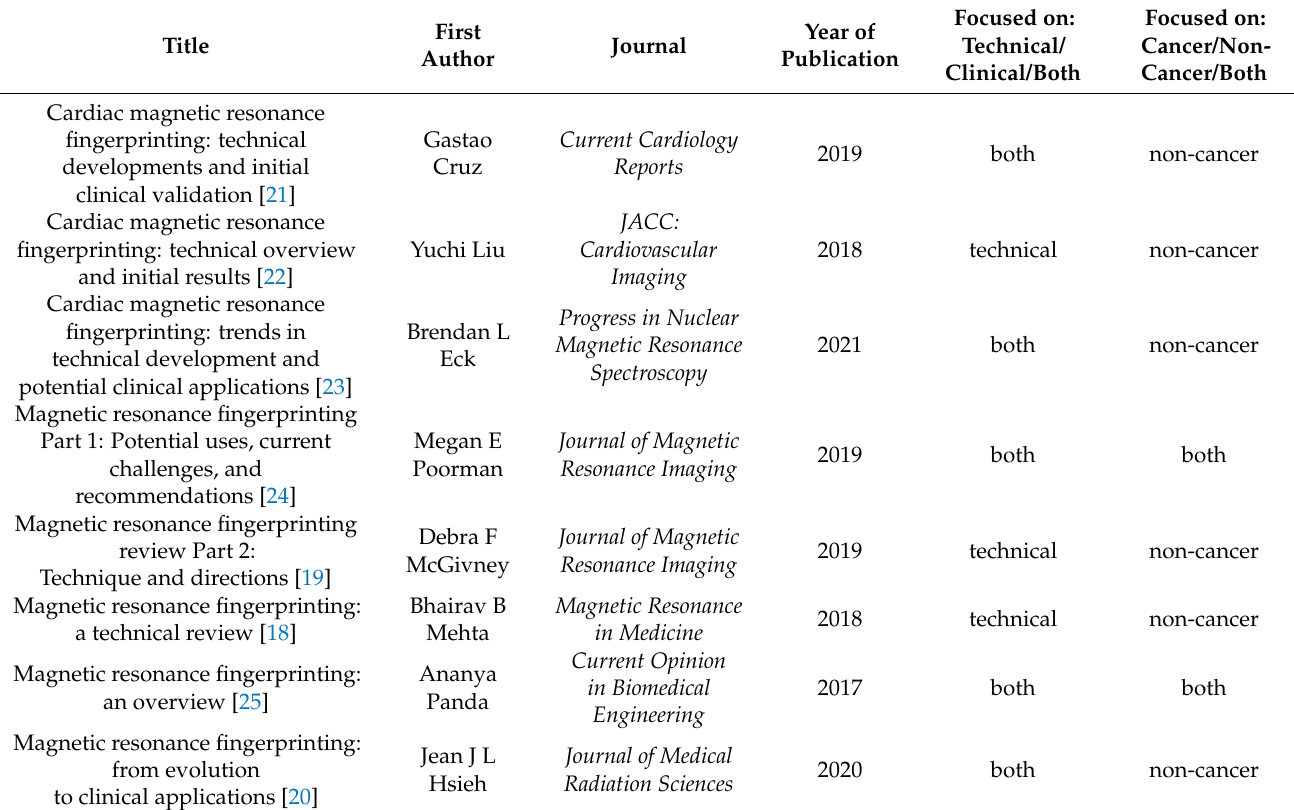
Table 1. Existing reviews on MRF with their areas of focus